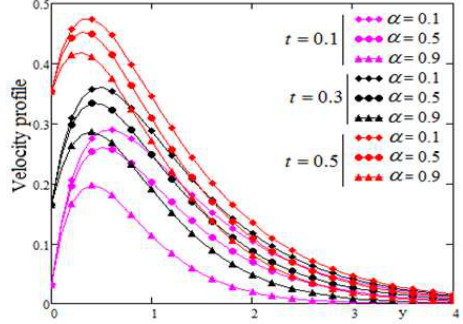
Figure 1. Profile of dimensionless velocity versus y for α variation with Pr = 0 . 7 , S = 5 , Sc = 0 . 8 , λ = 4 , Gr = 3 , Gm = 0 . 9 , M = 0 . 4 and different small values of time t .